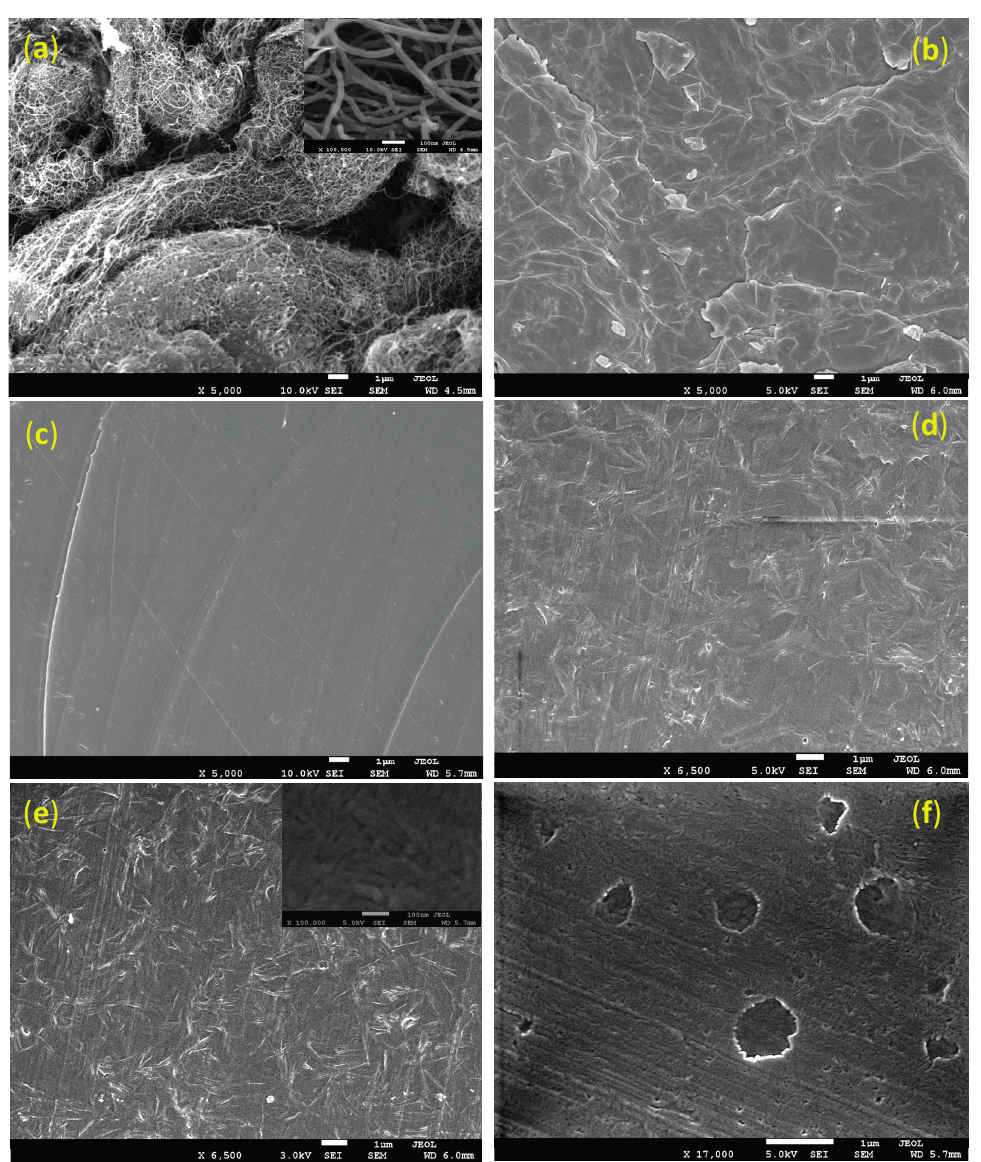
Figure 1. Scanning Electron Microscopy (SEM) images of ( a ) multi-walled carbon nanotubes (MWCNTs) as received; ( b ) neat polylactic acid (PLA); ( c ) epoxidized vegetable oils (ELO) plasticized PLA; ( d – f ) 2, 3 and 5 wt. % MWCNTs-reinforced PLA/ELO